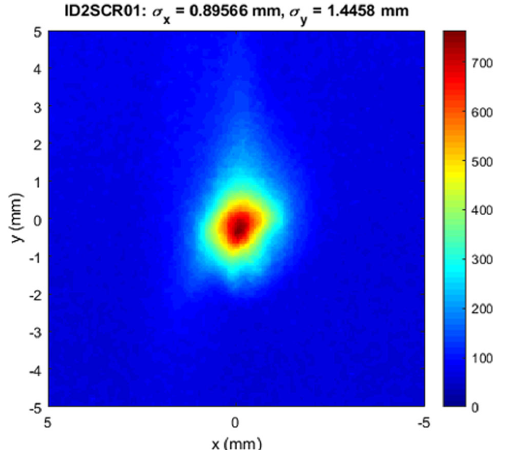
6. View screen of first recirculated beam on first screen in beam stop line.